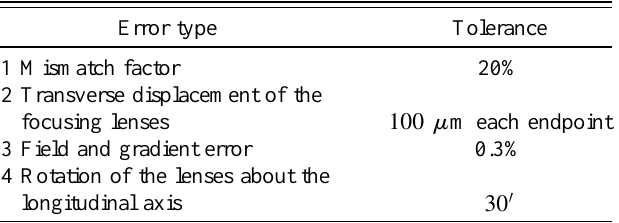
TABLE III. Twiss parameters of the matched beam at the entrance of solenoid for five charge states.